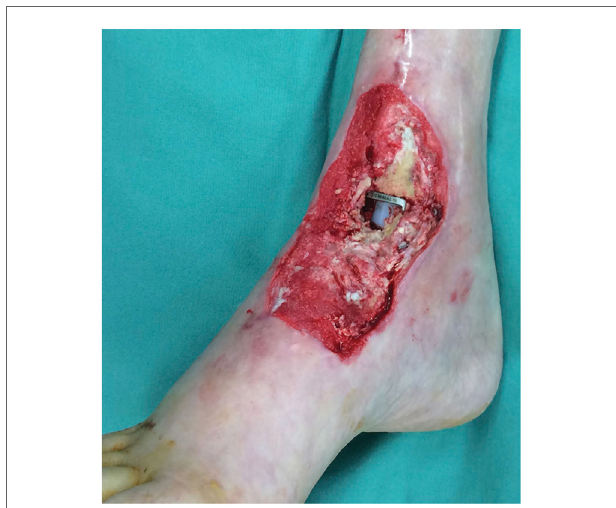
FiGURe 3 | Photograph of the soft tissue ankle defect showing the exposed metal hardware from a previous ankle reconstruction . Reproduced with permission from Microsurgery (109).